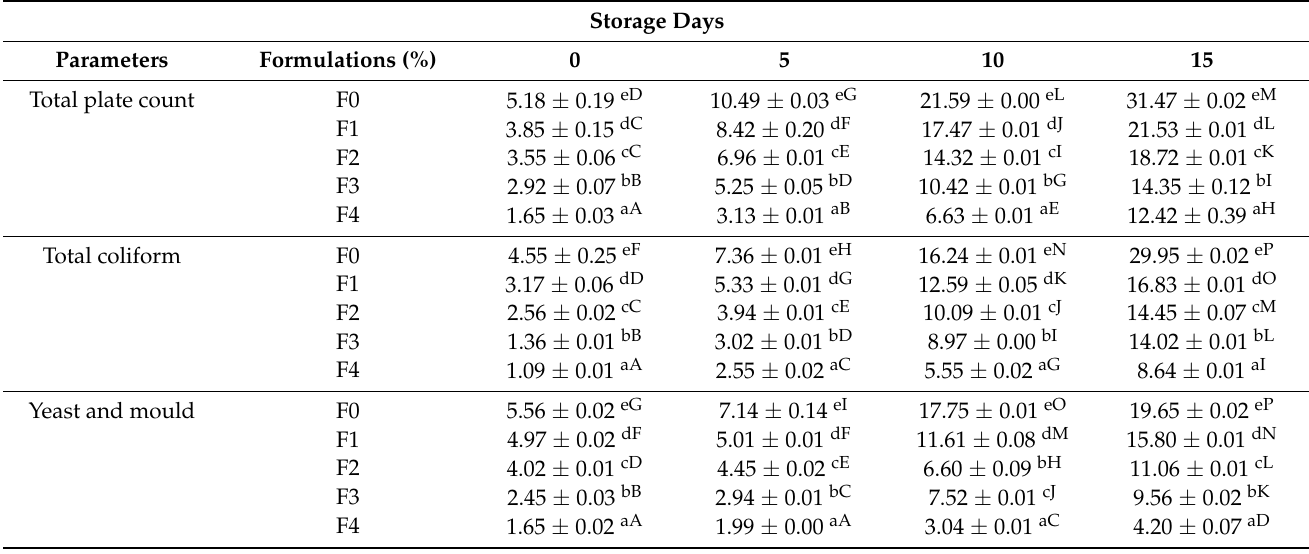
Table 3. Effects of MOLP on microbiological quality in colony forming unit (CFU)/g of ground beef stored at 4 ± 1 ◦ C for 15